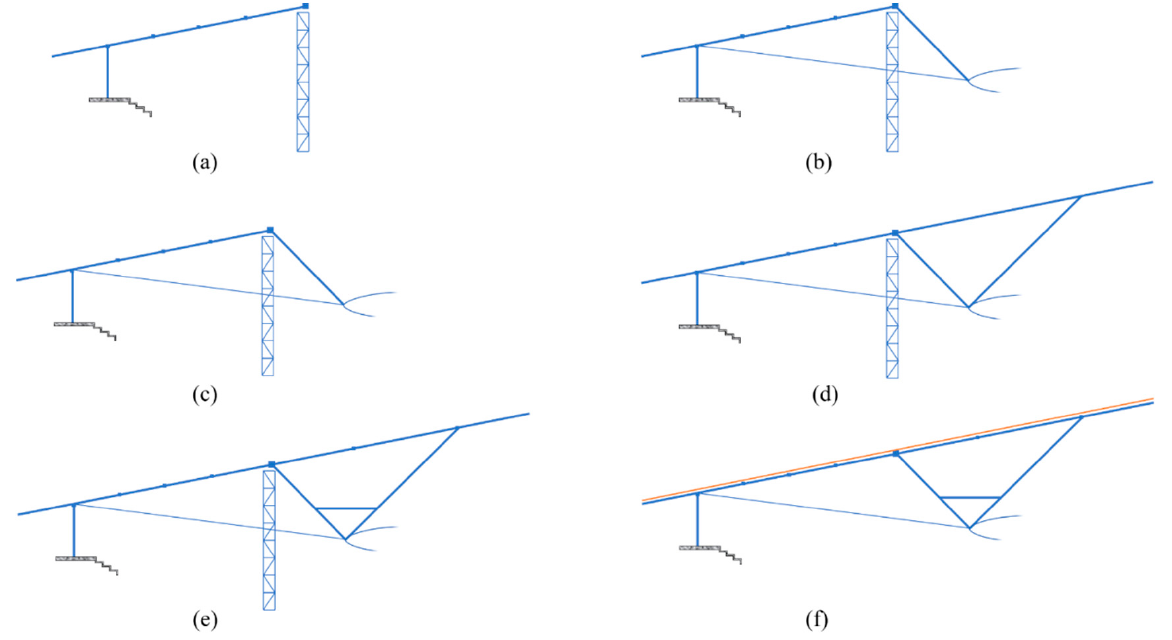
Figure 5. Construction process: ( a ) Step 1, ( b ) Step 2, ( c ) Step 3, ( d ) Step 4, ( e ) Step 5, ( f ) Step 6.